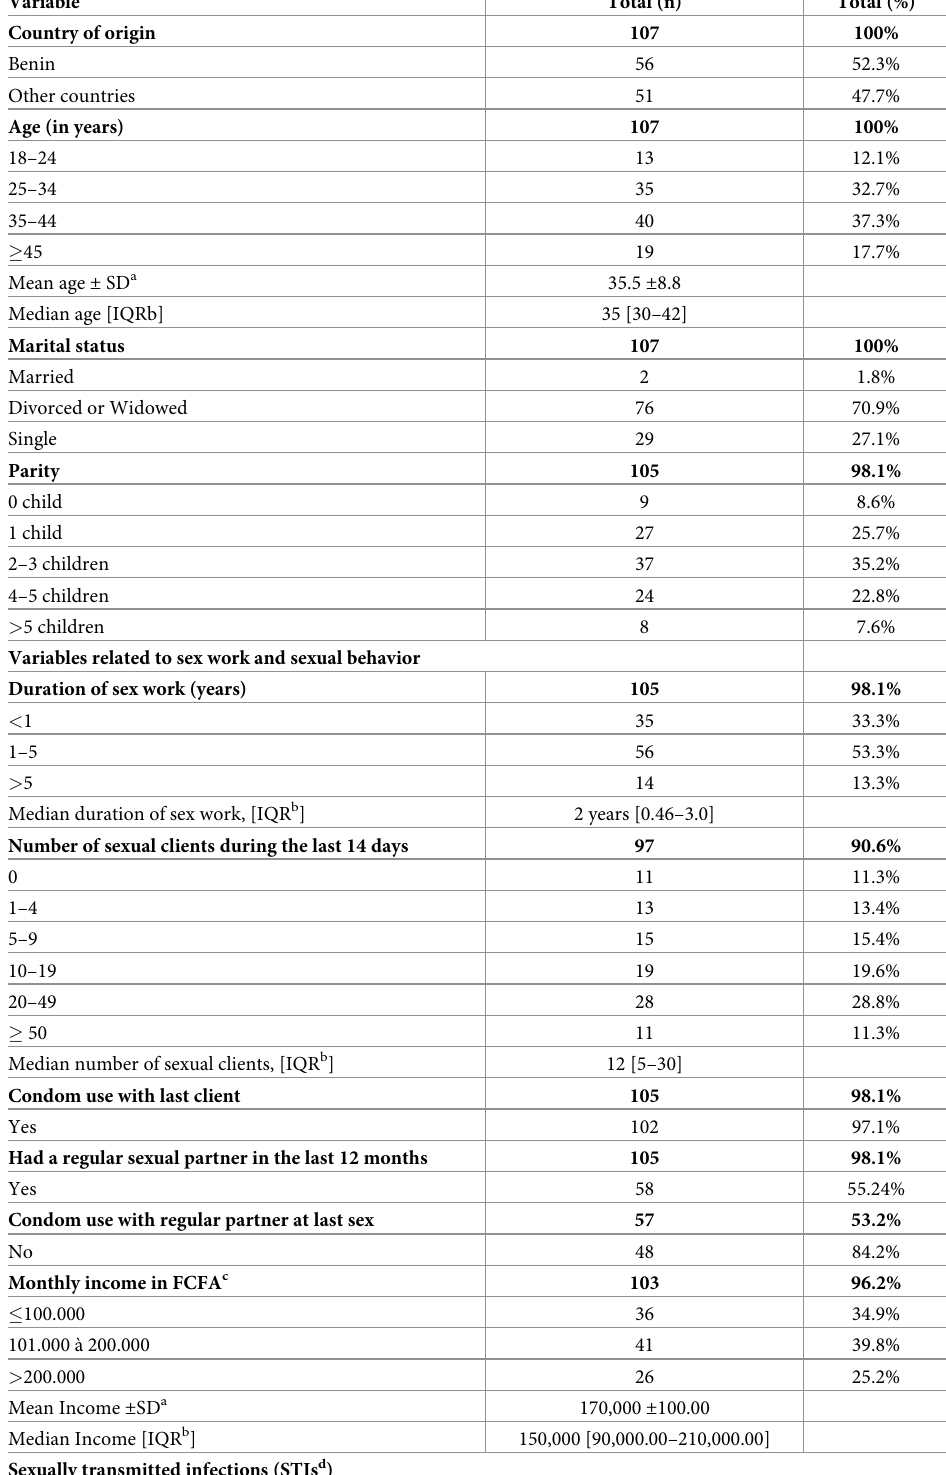
Table 1. Baseline characteristics of FSWs participating in the TasP demonstration study in Cotonou,